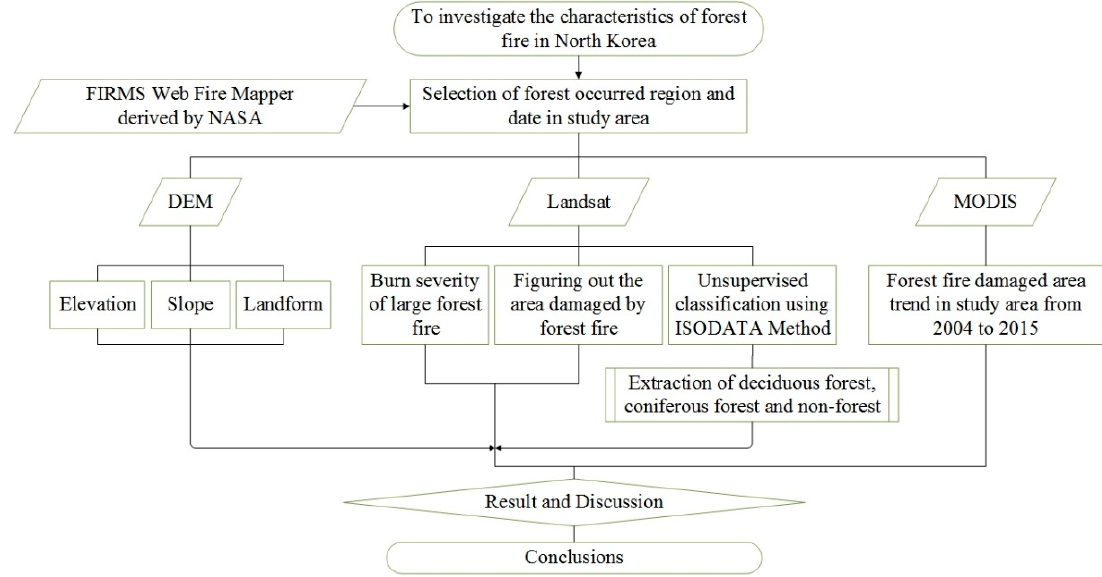
Figure 3. Flow chart of the procedures used in this study.